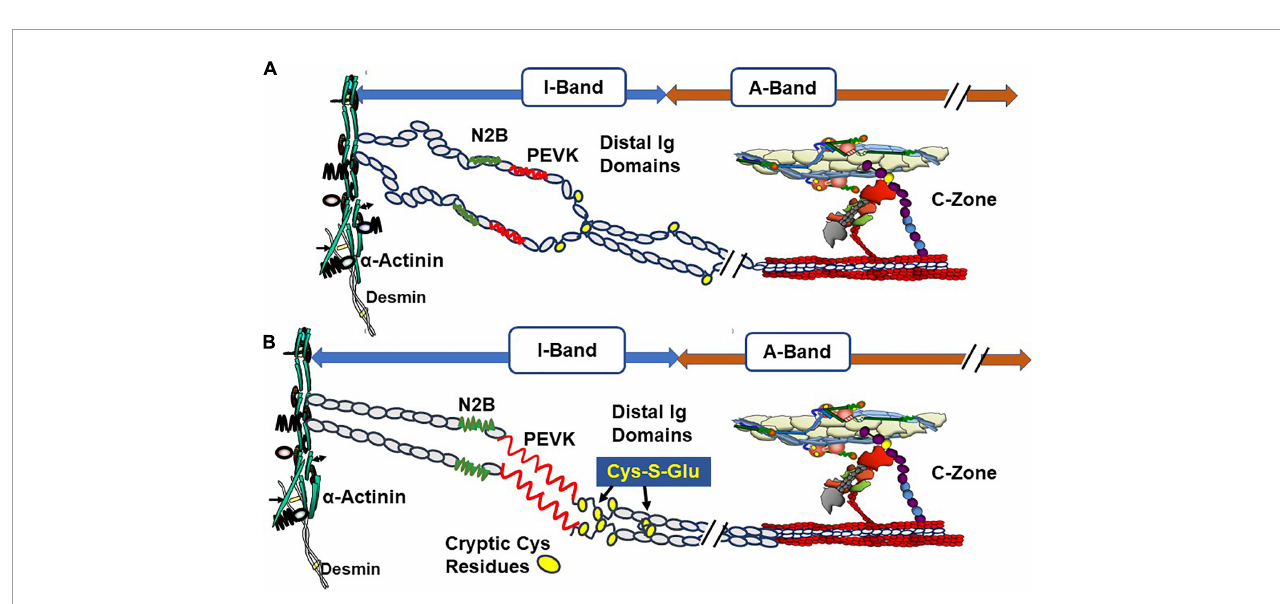
FIGURE3 Oxidative stress and length dependent stabilization of an unfolded state of titin distal Ig domains induced by exposure and S-glutathionylation of cryptic cysteine residues. (A) Illustration of stretch of titin in diastolic conditions with oxidant stress at a relatively short sarcomere length showing few exposed cysteines (yellow circles). (B) Illustration of stretch of titin with oxidant stress to a relatively long sarcomere length showing exposure of buried cysteine residues and S-glutathionylation. This figure is based on evidence reported by Loescher et al. (12) demonstrating that with mechanical and oxidant stress, stabilization of the state of distensibility of titin occurs with aggregation of distal Ig domains of parallel titin strands. Variations in this mechanism produce a range of values of passive tension and can affect length dependent activation (LDA). Evidence indicates that stretch of titin signals interactions with the C-terminal domains of cMyBP-C that are transmitted to the cMyBP-C N-terminal domains, which promote interactions with actin-Tm and activation of the thin filament. See text for further discussion.